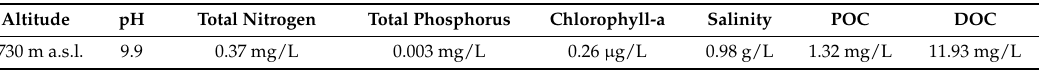
Table 1. Water characteristics of Lake Nam